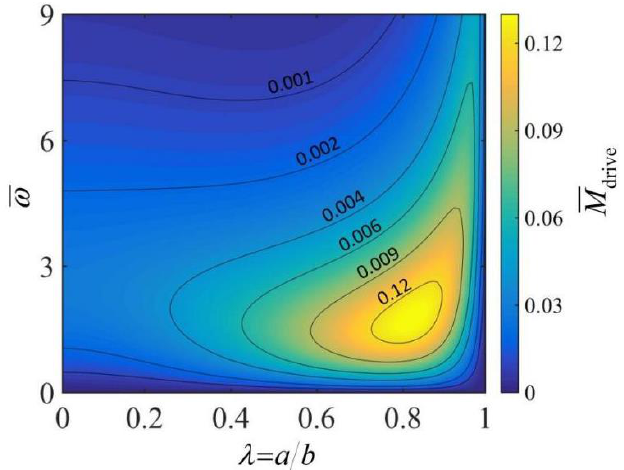
Figure 4. The effects of rolling angular velocity ω and radius ratio of the thick-walled cylindrical rod λ on the driving moment M drive . In the computation, we set: h = 0.3, L = 10, C T = 5 × 10 − 3 , q = 30 and θ 0 = 0.2. In this case, the rolling velocity of the rod is one of the output parameters. For a given angular velocity ω , there exists an optimal radius ratio λ corresponding to a maximum driving moment M drive .